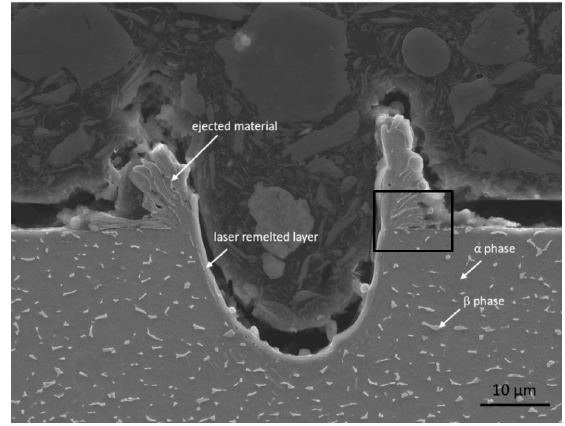
Figure 2. SEM micrograph of a laser channel obtained by the secondary detector. The black square marks the location of EBSD as shown in Figure 3.